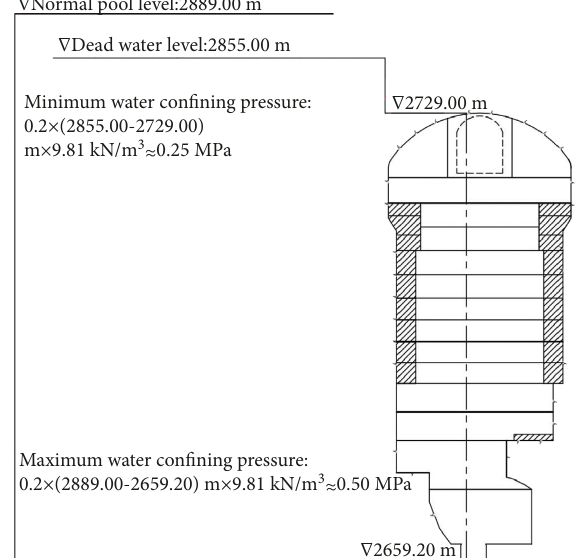
Figure 6: Schematic diagram of calculation.